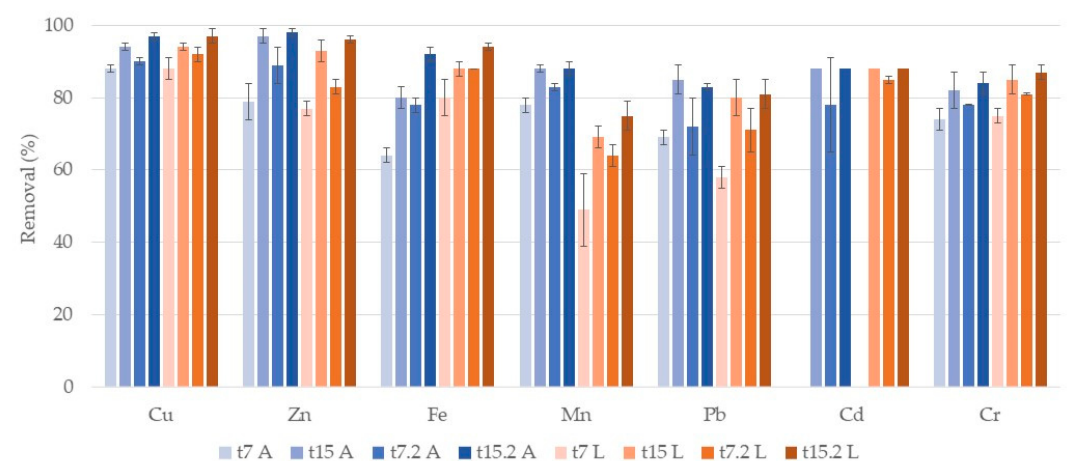
Figure 3. Removal percentage and respective standard deviation ( n = 3) for each metal, in CWs with P. australis and expanded clay (t7 A, t15 A, t7.2 A, t15.2 A) and lava rock (t7 L, t15 L, t7.2 L, t15.2 L) over the two cycles of treatment. First cycle: samples taken after one week (t7) and at the end of the two-week cycle (t15). Second cycle: samples taken after one week (t7.2) and at the end of the two-week cycle (t15.2). For Cd, there was no removal at t15.2 A.